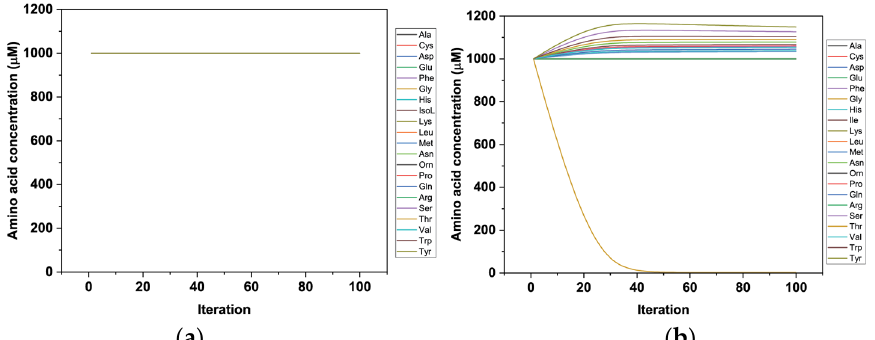
Figure 1. Simulation of symmetric and asymmetric antiporter kinetics in an artificial cell containing LAT2 only. The concentration of cytosolic and extracellular amino acids was set at 1 mM. ( a ) Intracellular concentrations of all substrate amino acids when LAT2 intracellular K M values were scaled to be 180-fold higher than extracellular K M values. ( b ) Intracellular concentrations of all substrate amino acids when the intracellular K M value of Gly was scaled to be 0.6-fold higher than the extracellular K M value (all other K M values as in ( a )). Gly (beige) is leaving the cell in exchange for all other substrates of the transporter.